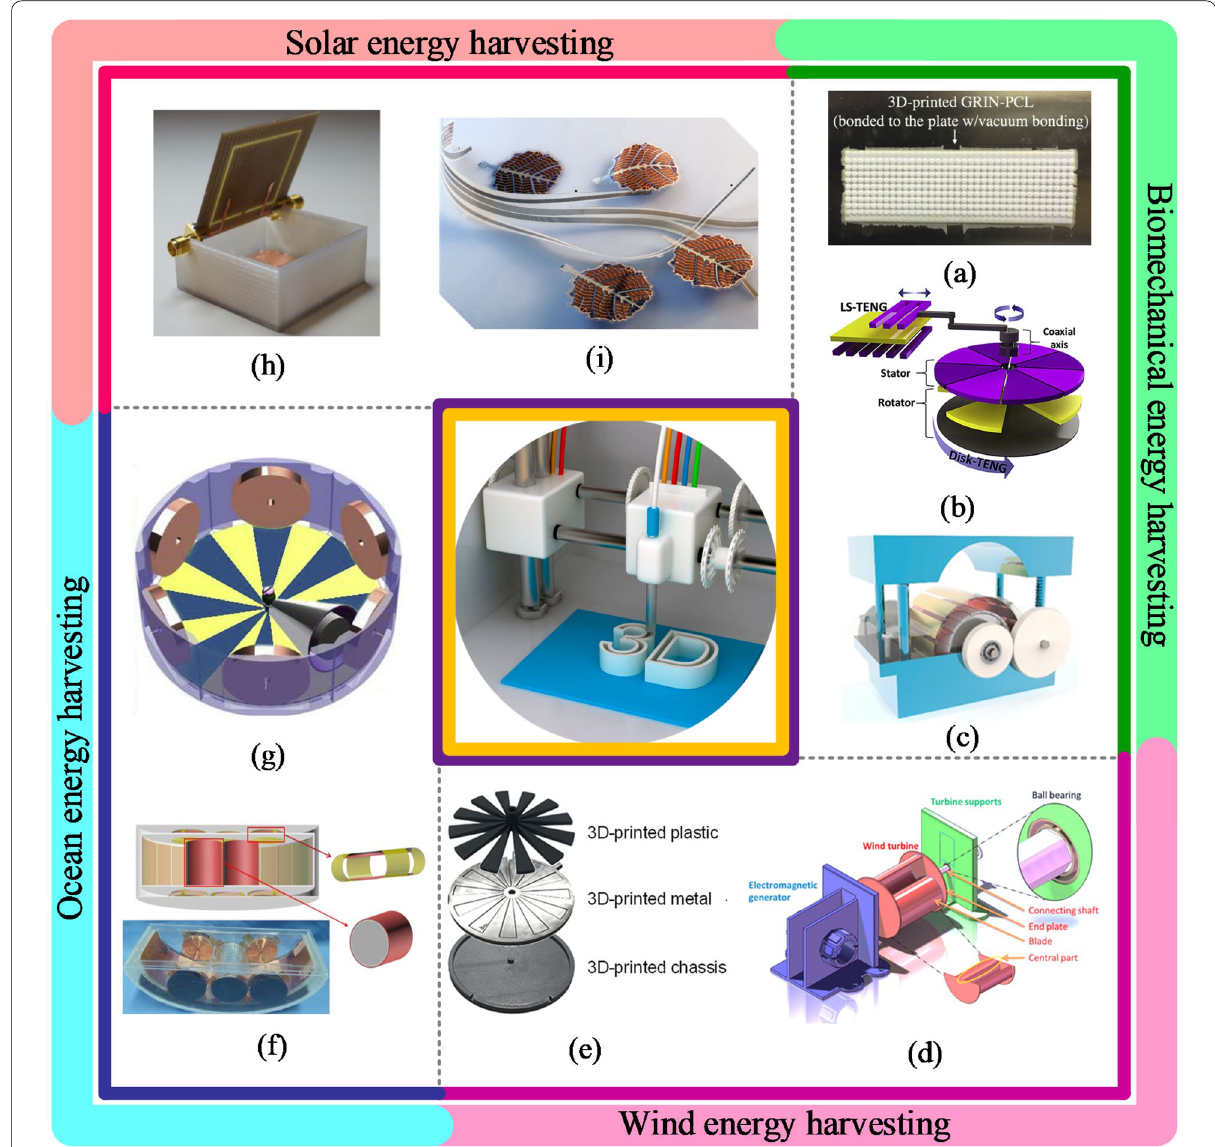
Fig. 5 Various sources of MEH through 3D-printed MEH devices a 3D-printed phononic crystal lens for elastic wave energy harvesting [30] b 3D-printed hybrid coaxial TENG inspired by a crank engine [27] c Bidirectional gear transmission triboelectric nanogenerator fabricated using 3D printing [31] d 3D printed miniature electromagnetic energy harvester driven by airflow [26] e All 3D printed grating disk type TENG [25] f ship-shaped hybridized nanogenerator [78] g triboelectric-electromagnetic rotating gyro structured blue energy harvester [32], h Solar energy harvester with a 3-D printed package [84] i 3D printed solar energy trees (Image credits: alternative-energy-news.info/) (Images are re-used with the permission of the